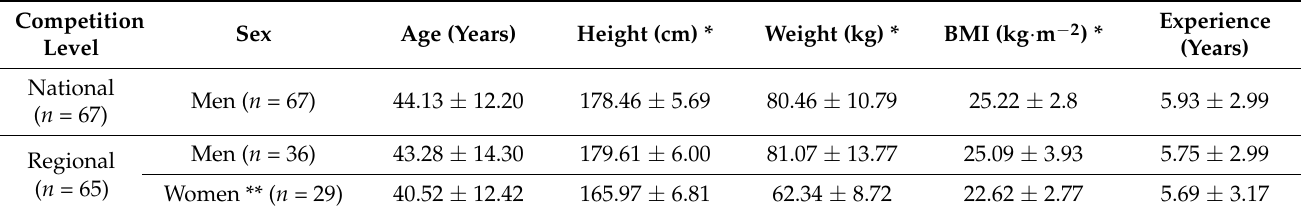
Table 1. Descriptive data of the open water swimmers at the regional and national